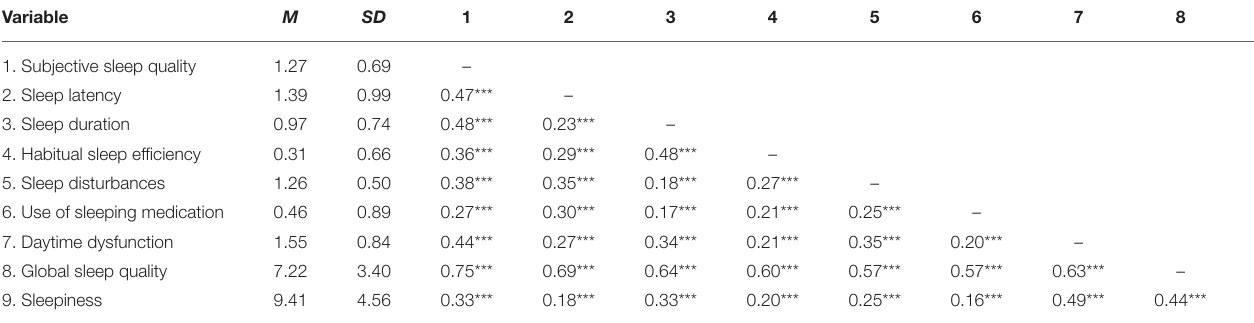
TABLE 2 | Means, standard deviations, and correlations. Variable